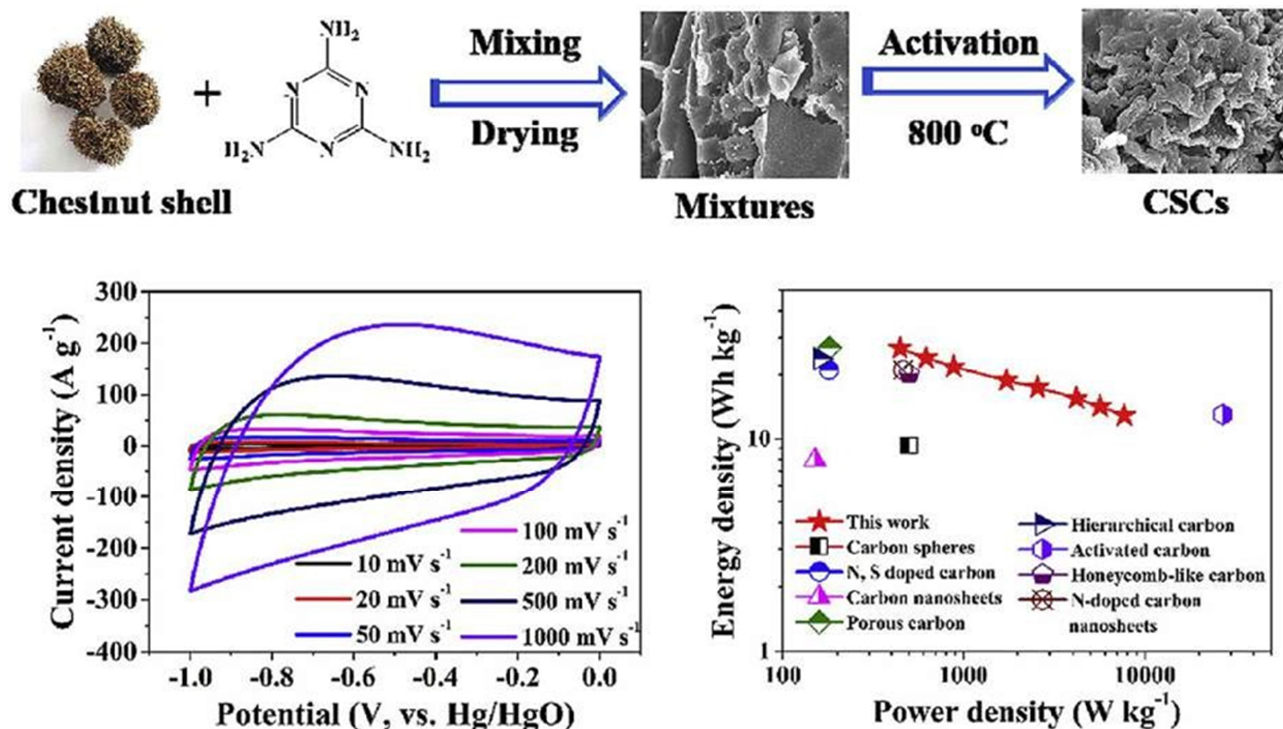
Figure 28. Superior performance in supercapacitors using multi-heteroatom-doped hierarchical porous carbon produced from chestnut shells. Reproduced with permission from [109].